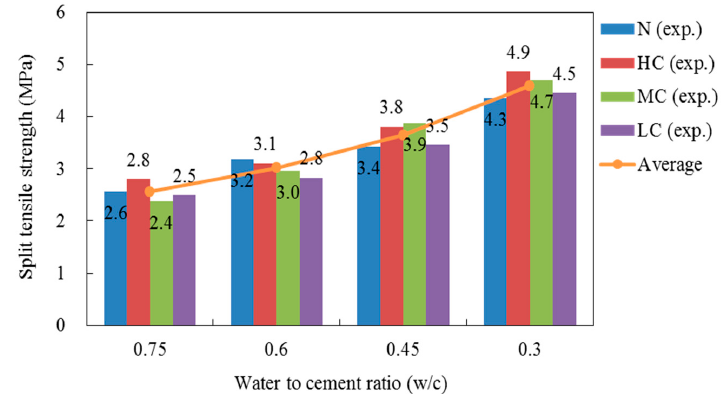
Figure 9. Split tensile strength of concrete with different water-to-cement